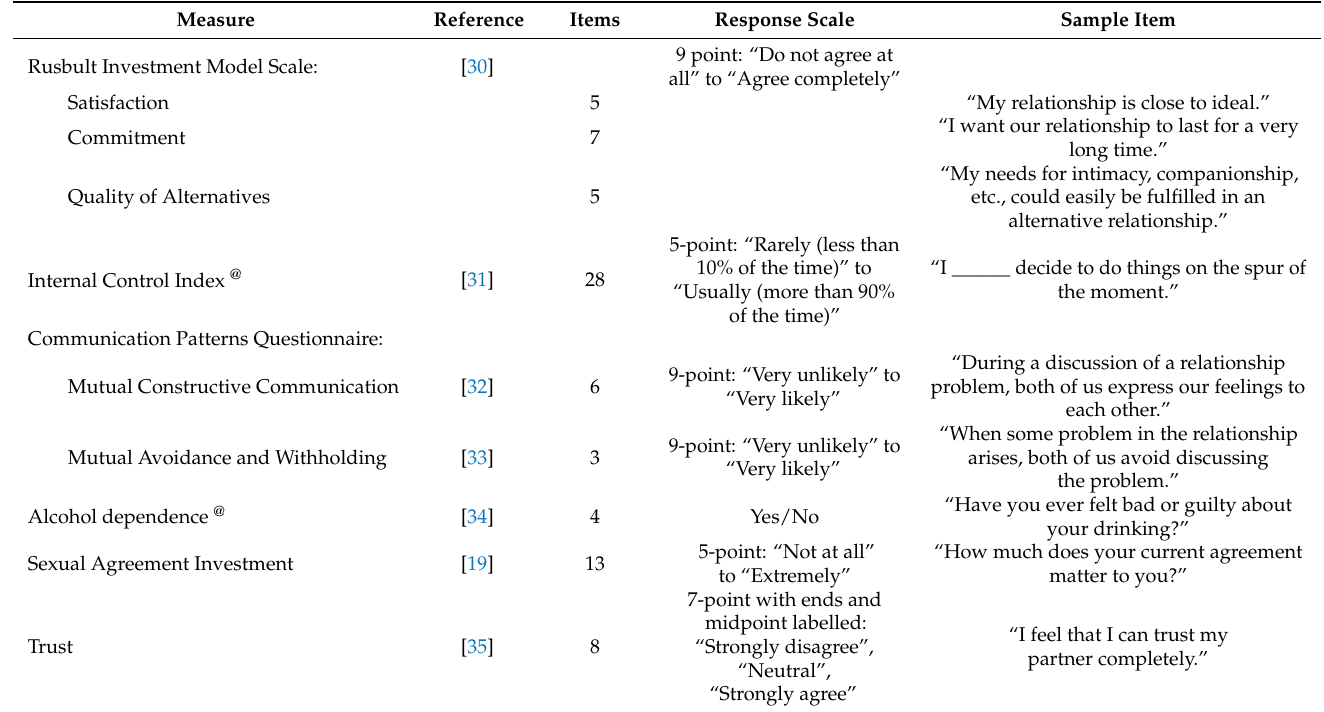
Table 1. Relationship